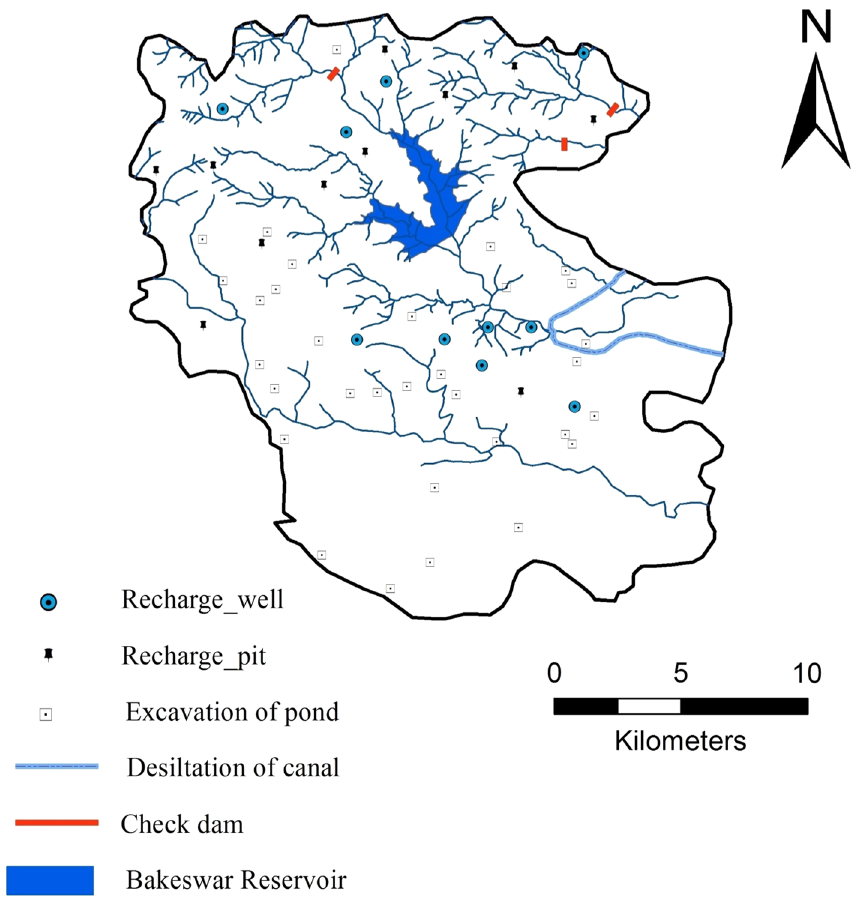
Fig. 5 Receiver operating characteristics curve (ROC) for validation of groundwater potential zone. AUC = 0.698 Fig. 6 Groundwater